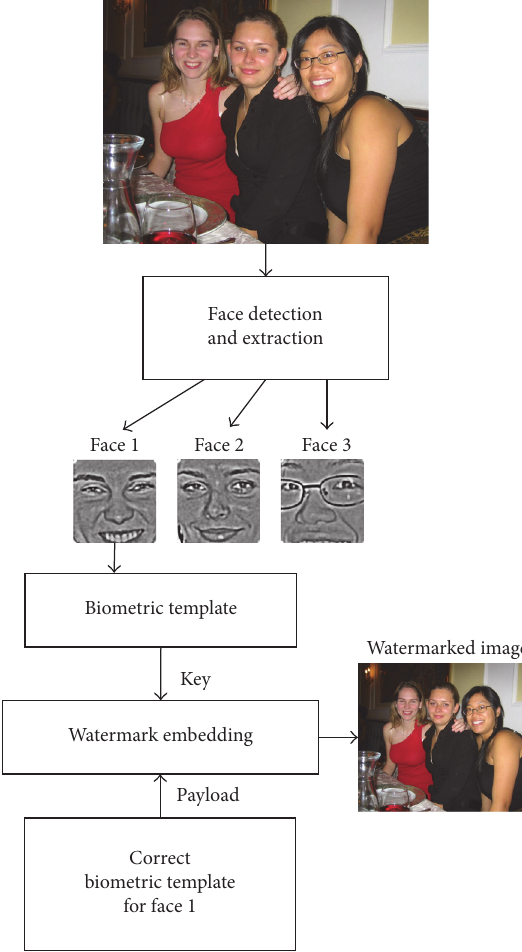
Figure 1: General overview of the embedding process of our proposed scheme. The same process is repeated for all of the faces in the